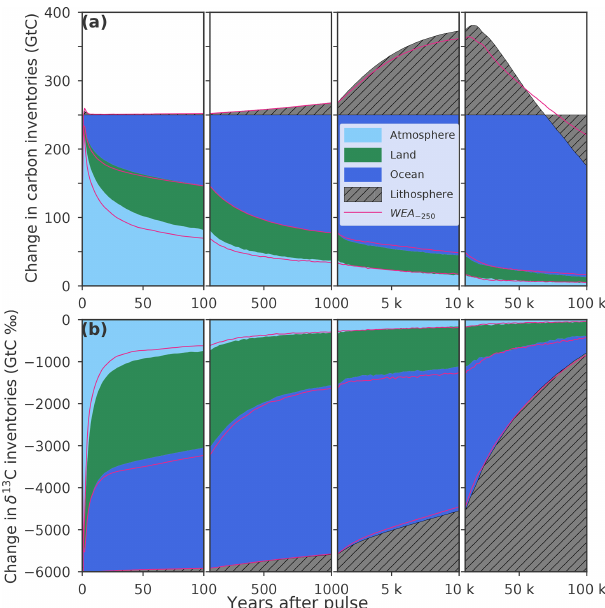
Figure 3. Inventories of the (a) carbon and (b) δ 13 C perturbations for experiment WEA 250 . Shown are inventories of the perturba- tions in the atmosphere (light blue), the land biosphere (green), and the ocean (blue). Hatching indicates the influence of changes in the lithosphere (including sediments) due to CaCO 3 compensa- tion and imbalances in the weathering and burial fluxes on the car- bon and isotopic inventories of the ocean–atmosphere–land system. For carbon, this inventory is elevated above the pulse perturbation of 250GtC until about 70kyr and depleted thereafter. For δ 13 C, the atmosphere–ocean–land inventory is continuously reduced over the course of the simulation. Magenta lines show results for experiment WEA − 250 multiplied by −